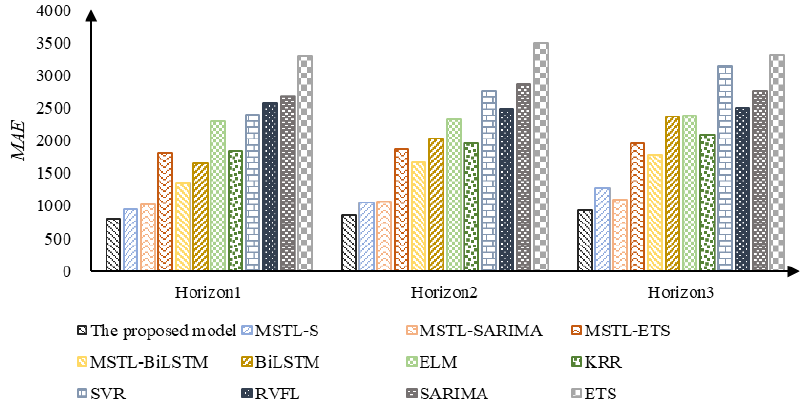
Figure 8. MAE of each model in multi-step-ahead forecasting.